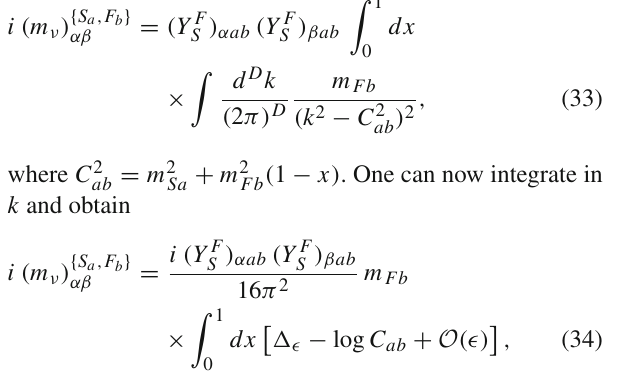
Fig. 7 Generic one-loop contribution to the neutrino mass matrix. F and S represent fermion and scalar mass eigenstates contributing to the neutrino mass